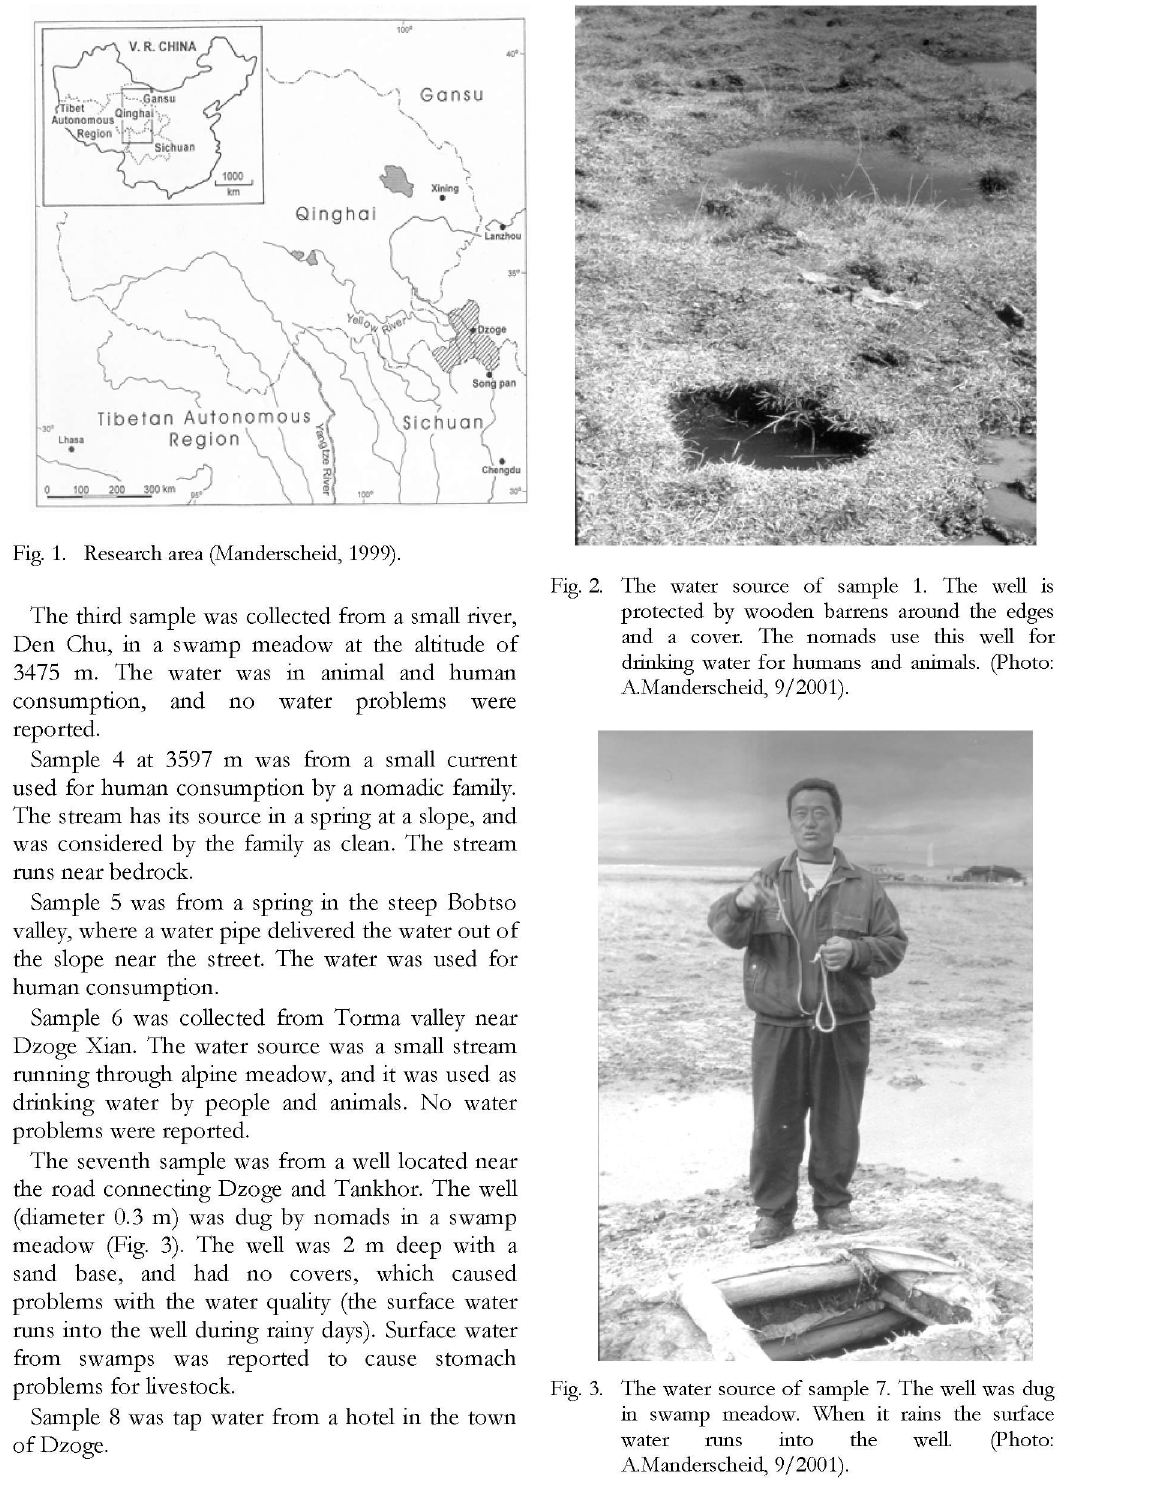
Fig. 3. The water source of sample 7. The well was dug in swamp meadow. When it rains the surface water runs into the well. (Photo: AManderscheid,